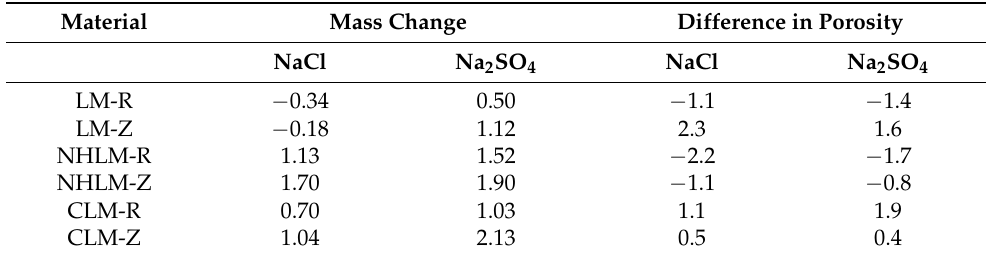
Table 8. Mass change (wt.%) and difference in porosity (absolute%) after salt crystallization test. Material